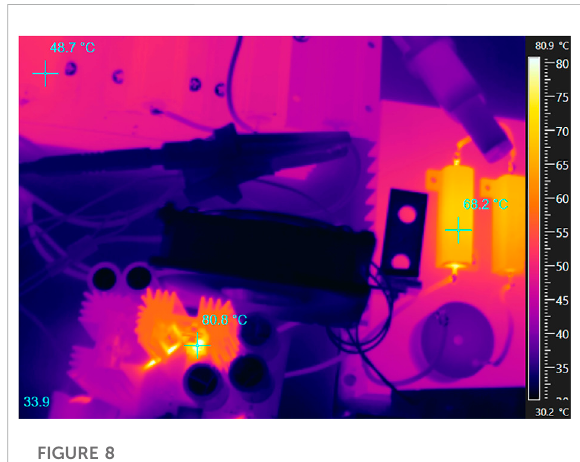
FIGURE 6 Active load circuit test bench.